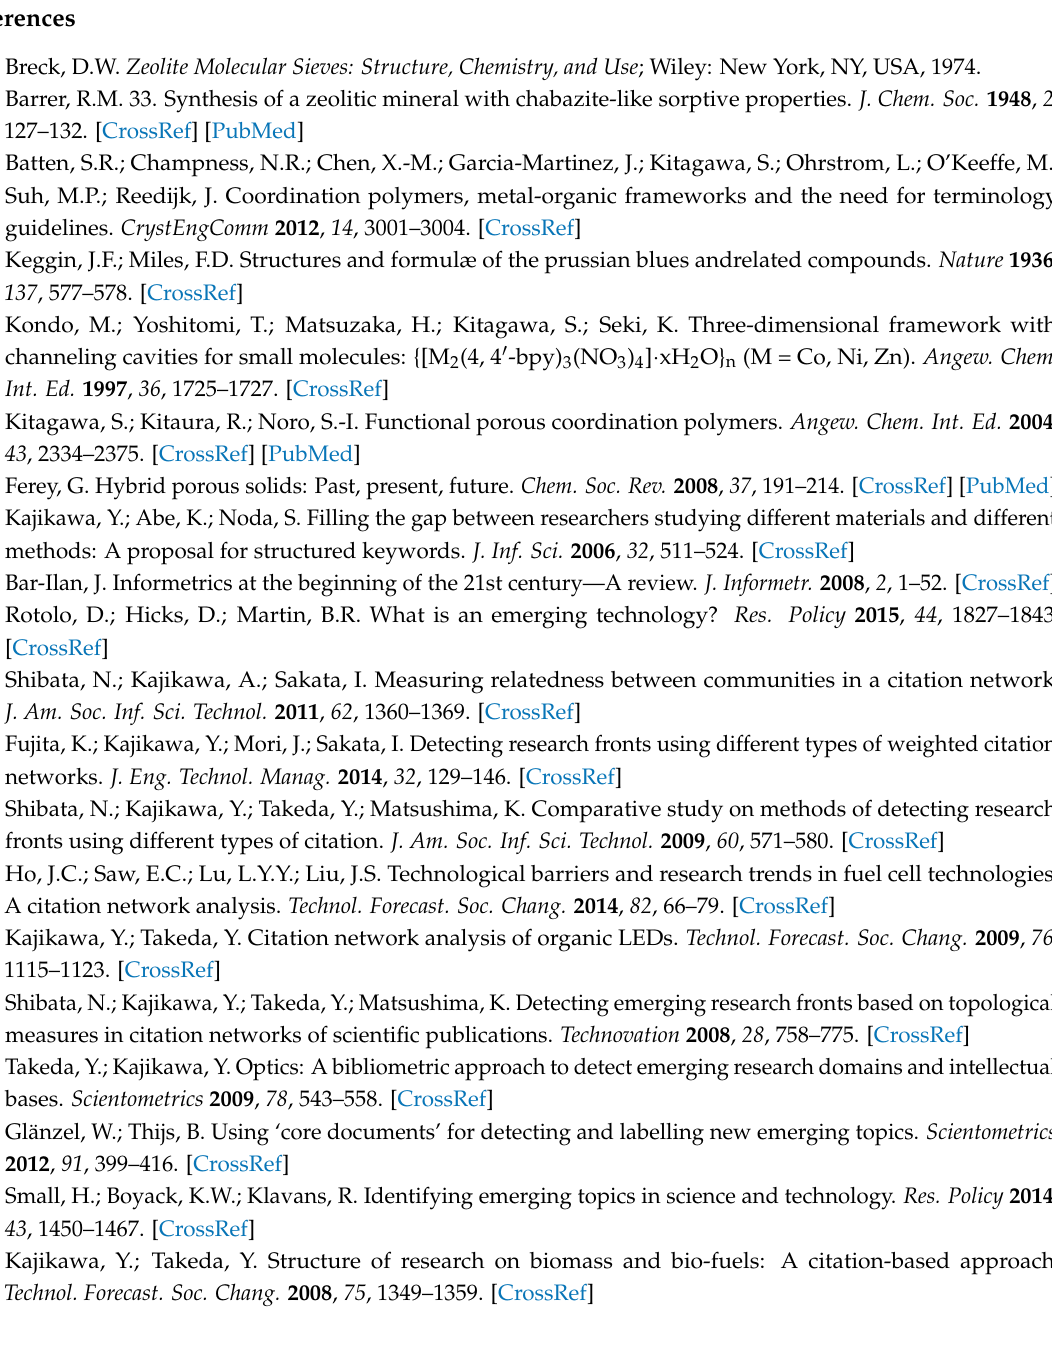
Table S1: Effect of simulated impact factor for rest of journals, calculation of synthetic costs for zeolites and